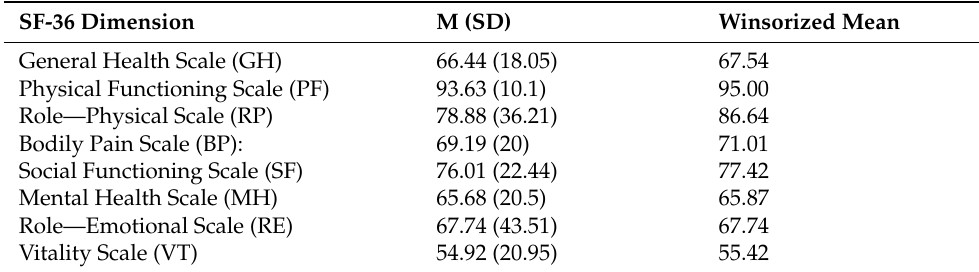
Table 4. Scores obtained in SF-36 ( n = 62).